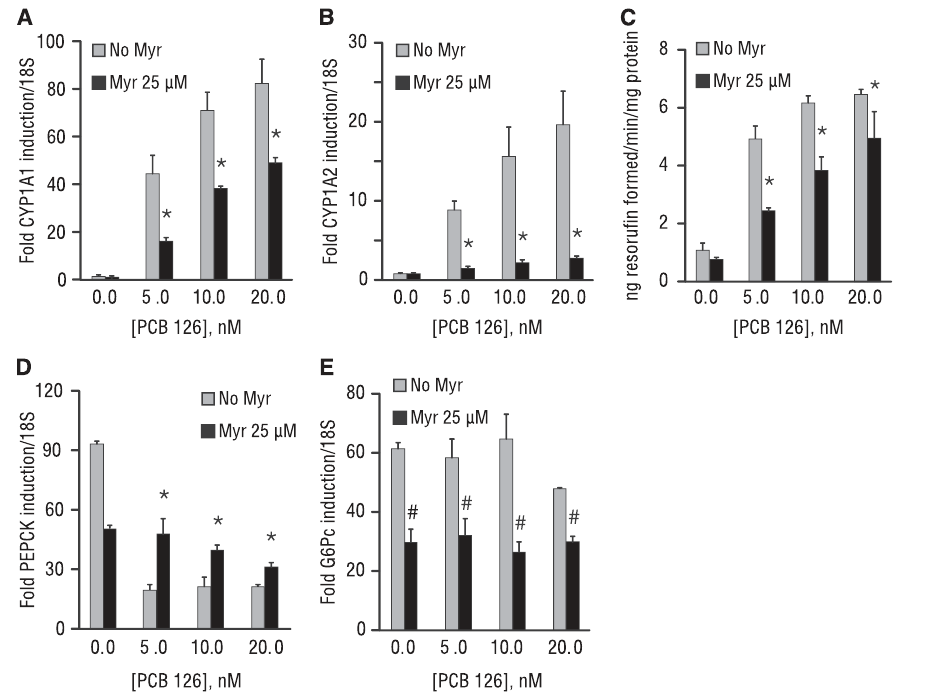
Figure 5. Validation and evaluation of myricetin, a putative competitive AhR inhibitor. Doses of PCB 126 were selected based on the concentrations near the middle (5 nM) or top (10–20 nM) of the respective dose-response curves (established in figure 4). (A) Maximally effective myricetin doses (25 m M) significantly antagonize PCB 126 –induced CYP1A1 gene expression. (B) Similar effect of 25 m M myricetin on PCB 126 induction of CYP1A2 gene expression. (C) 25 m M myricetin antagonizes EROD activity induction by PCB 126. (D) Myricetin homogeneously suppresses forskolin-induced PEPCK expression and also restores PEPCK gene induction by forskolin in the presence of PCB 126. (E) Myricetin homogeneously suppresses forskolin-induced G6pc gene induction by PCB 126, which has no impact on forskolin induction of G6pc expression. (Panels A–C) *p , 0.05 for myricetin effect with respective PCB 126 concentration. (Panels D–E) # p , 0.05 for myricetin effect within each [PCB 126]. (All panels) Data are average of 2–3 experiments; error bars are 2 / +